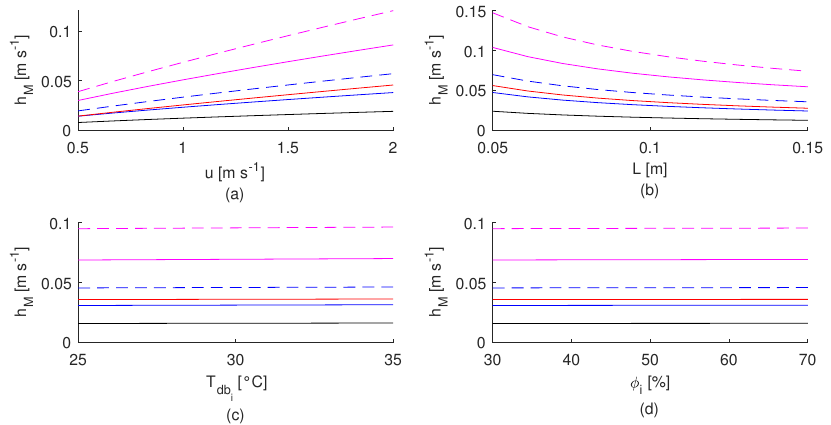
Figure 4. Comparison of the convective mass transfer coefficient ( h M ) for different pad materials and their dependency of the operative and constructive variables as air velocity ( u ), pad thickness ( L ), dry-bulb temperature of inlet air ( T db ) and relative humidity ( φ i ). ( a ) h M as a function of u . i ( b ) h M as a function of L . ( c ) h M as a function of T db . ( d ) h M as a function of φ i . For each plot the i other parameters remained constants: u = 1.5 m s − 1 , L = 0.1 m, T db = 30 ◦ C and φ i = 60%. CL pad: i black solid line, CS 1 pad: blue solid line, CS 2 pad: blue dashed line, BC pad: red solid line, PS 1 pad: magenta solid line, PS 2 pad: magenta dashed